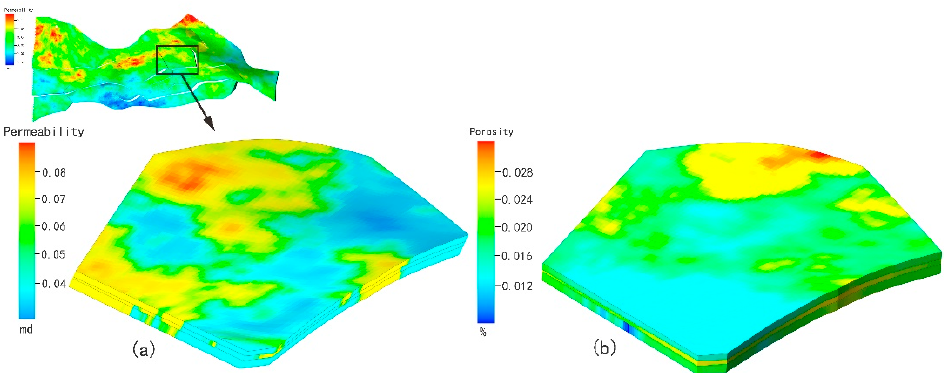
Figure 3. Reservoir initial distribution of permeability and porosity.